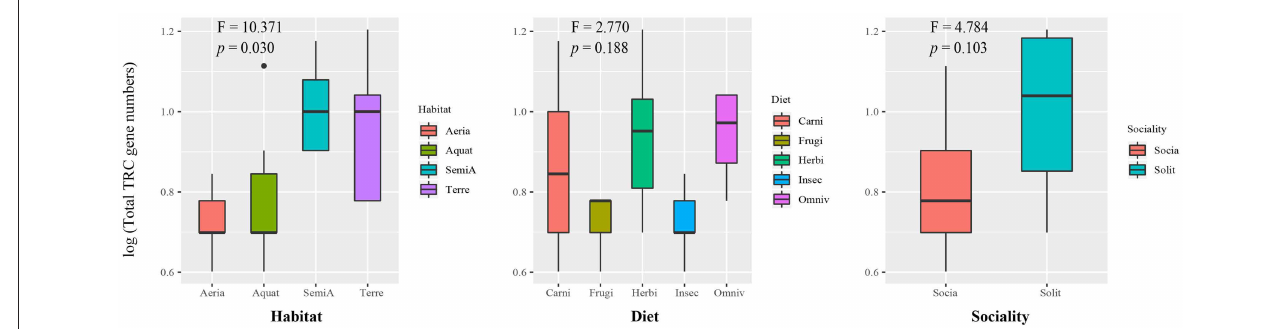
FIGURE 2 | Box plot for comparison of total TRC repertoires among groups of divergent ecological niches. X axis: categories of ecological factors. Y axis: total number of TRC genes after log transformation. F -value and p- value on the boxplot are extracted from results of phyANOVA. Aquat-Aquatic; SemiA-SemiAquatic; Terre-Terrestrial; Carni-Carnivore; Frugi-Frugivore.